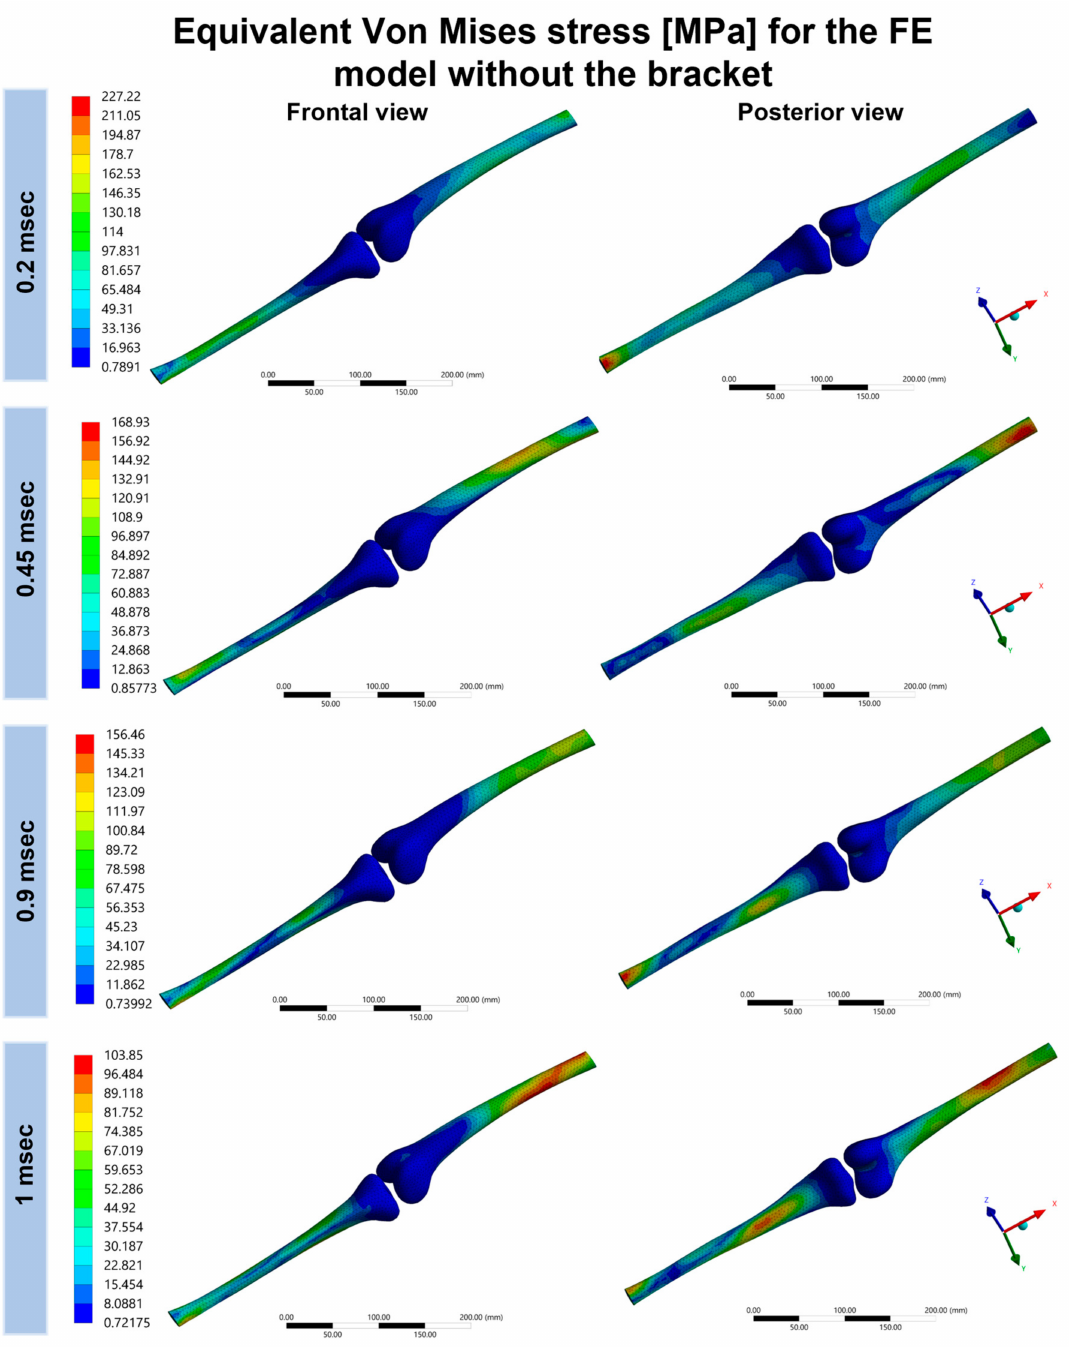
Figure 9. Equivalent Von Mises stress distribution in the bone component of the limb for the FE model without